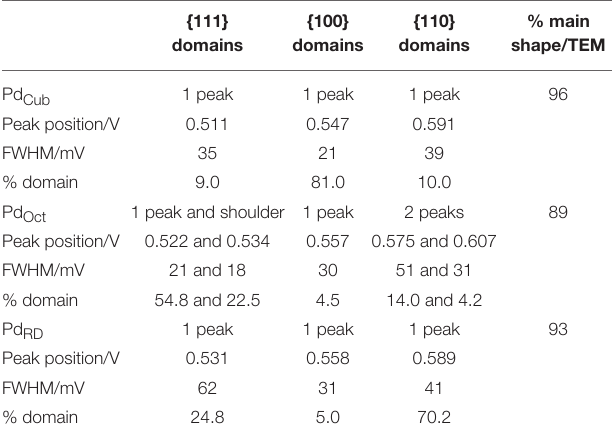
TABLE 3 | Main results of the deconvolution process of the Cu UPD voltammograms on Pd Cub , Pd Oct , and Pd RD nanoparticles shown in Figure 6